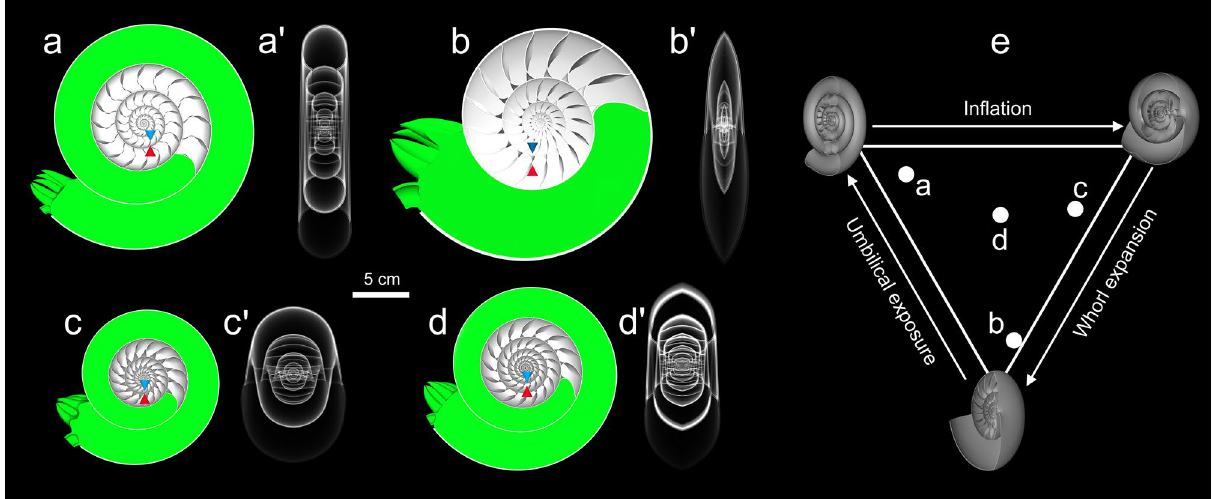
Figure 9. Hydrostatic models of theoretical planispiral cephalopods. These models were constructed by morphing a Nautilus pompilius conch into ammonoid shapes (see “Methods”): ( a ) oxycone, ( b ) serpenticone, ( c ) sphaerocone, and ( d ) morphospace center. The centers of buoyancy and mass are denoted by the tips of the blue (upper) and red (lower) cones. Prime symbols ( ′ ) refer to transparent, transverse views of each respective conch shape. ( e ) Westermann morphospace 22 showing relative positions of these conch shapes. All models were rendered in MeshLab 76